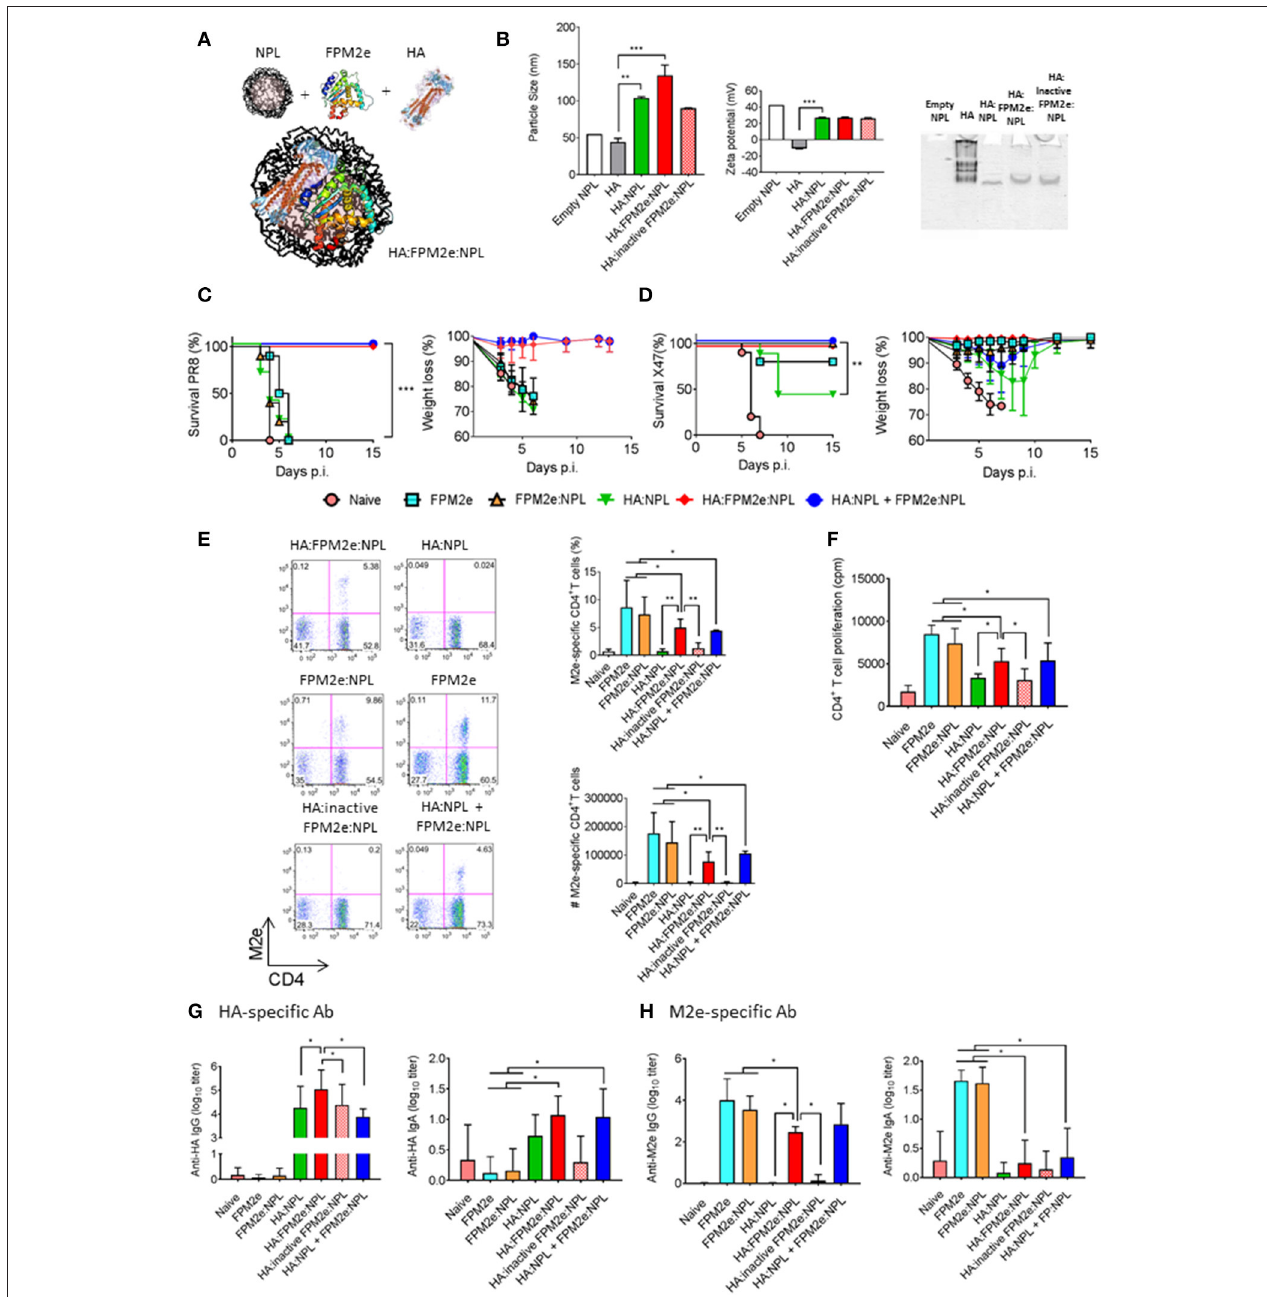
FIGURE 4 | Enhanced immunogenicity and protection by co-incorporation of recombinant HA and FPM2e in the combined NPL vaccine vector. (A) A schematic representation of the HA:FPM2e:NPL vaccine vector. (B) The combined HA:FPM2e:NPL vector was characterized with regard to particle size (left panel), zeta potential (middle panel) and native-PAGE electrophoresis analysis (right panel). (C,D) Survival and weight loss was monitored in influenza virus challenged Balb/c mice following three i.n immunizations with 5 µ g of vaccine formulations as indicated. The percent of surviving mice (left panel) and body weight loss (right panel) following a challenge infection with 4 × LD50 of the mouse adapted X47 (C) or PR8 (D) virus strains. (E) Representative FACS plots of M2e-tetramer + CD4 + T cells in the lungs of i.n immunized and challenged mice are shown. The percentage and absolute numbers (right panels) of antigen primed M2e + tetramer CD4 + T cells in the lung. (F) Recall responses of primed M2e-specific CD4 + T cells in the spleens of immunized mice are given as mean cpm ± SD of 3 independent experiments. (G,H) HA- (G) or M2e-specific (H) IgG antibodies in serum (left panel) and IgA antibodies in BAL (right panel) were determined by ELISA in immunized mice as indicated and the mean log 10 -titers ± SD are given. These are representative results from three experiments giving similar results and the statistical significance was calculated using unpaired t -test and p -values are * p < 0.05, ** p < 0.01 and *** p < 0.005.